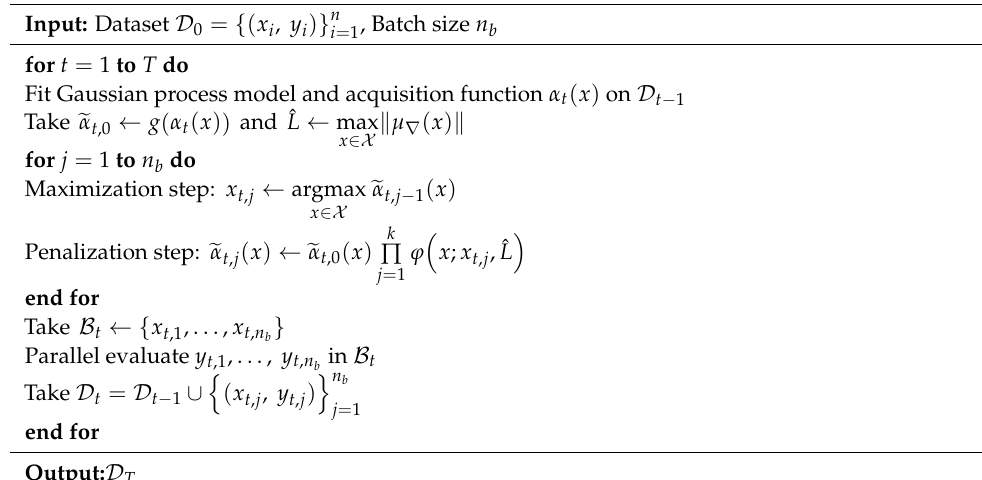
Algorithm 2. The pseudocode of